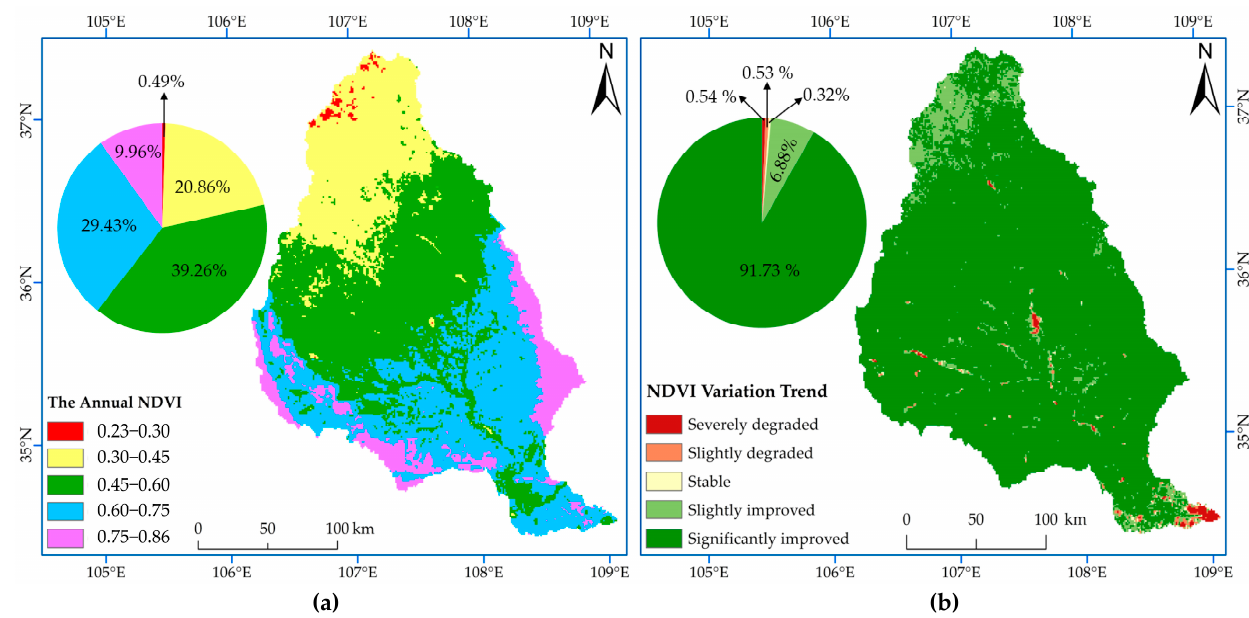
Figure 11. ( a ) Spatial distribution of the NDVI mean. ( b ) Annual mean NDVI variation trend. Table 5. Trend of the NDVI in the JRB.